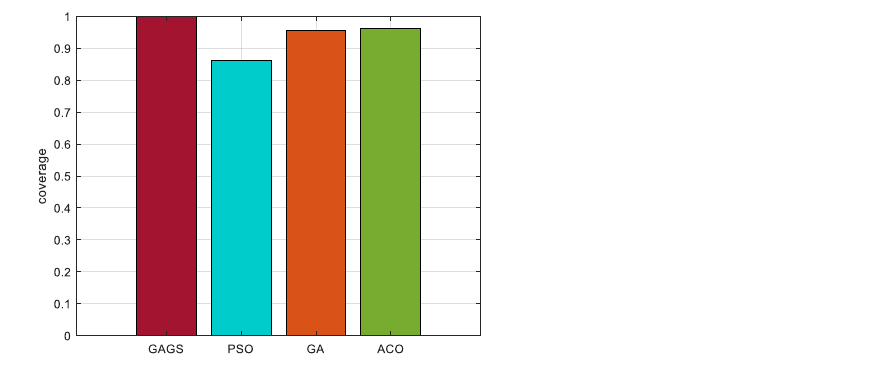
Figure 14. Histogram of algorithm coverage comparison after reducing the coverage threshold.